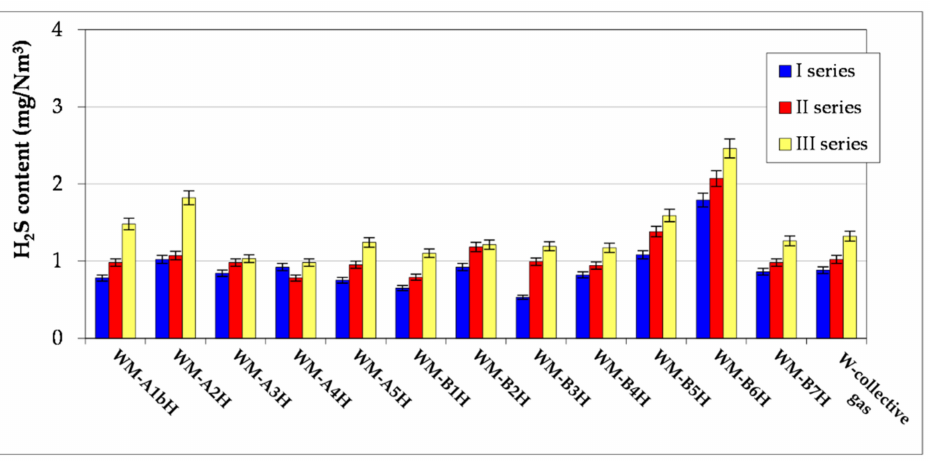
Figure 5. A comparison of H 2 S content in natural gas from individual horizontal wells in the XXV exploitation